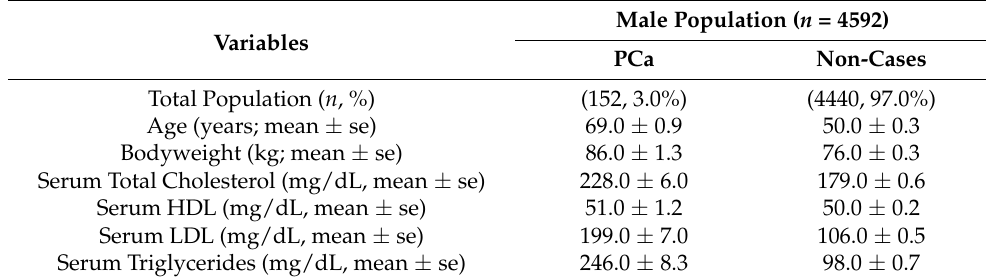
Table 2. Descriptive statistics (numerical variables) PCa status and selected covariates among men ≥ 20 years of age; NHANES 2005–2015.